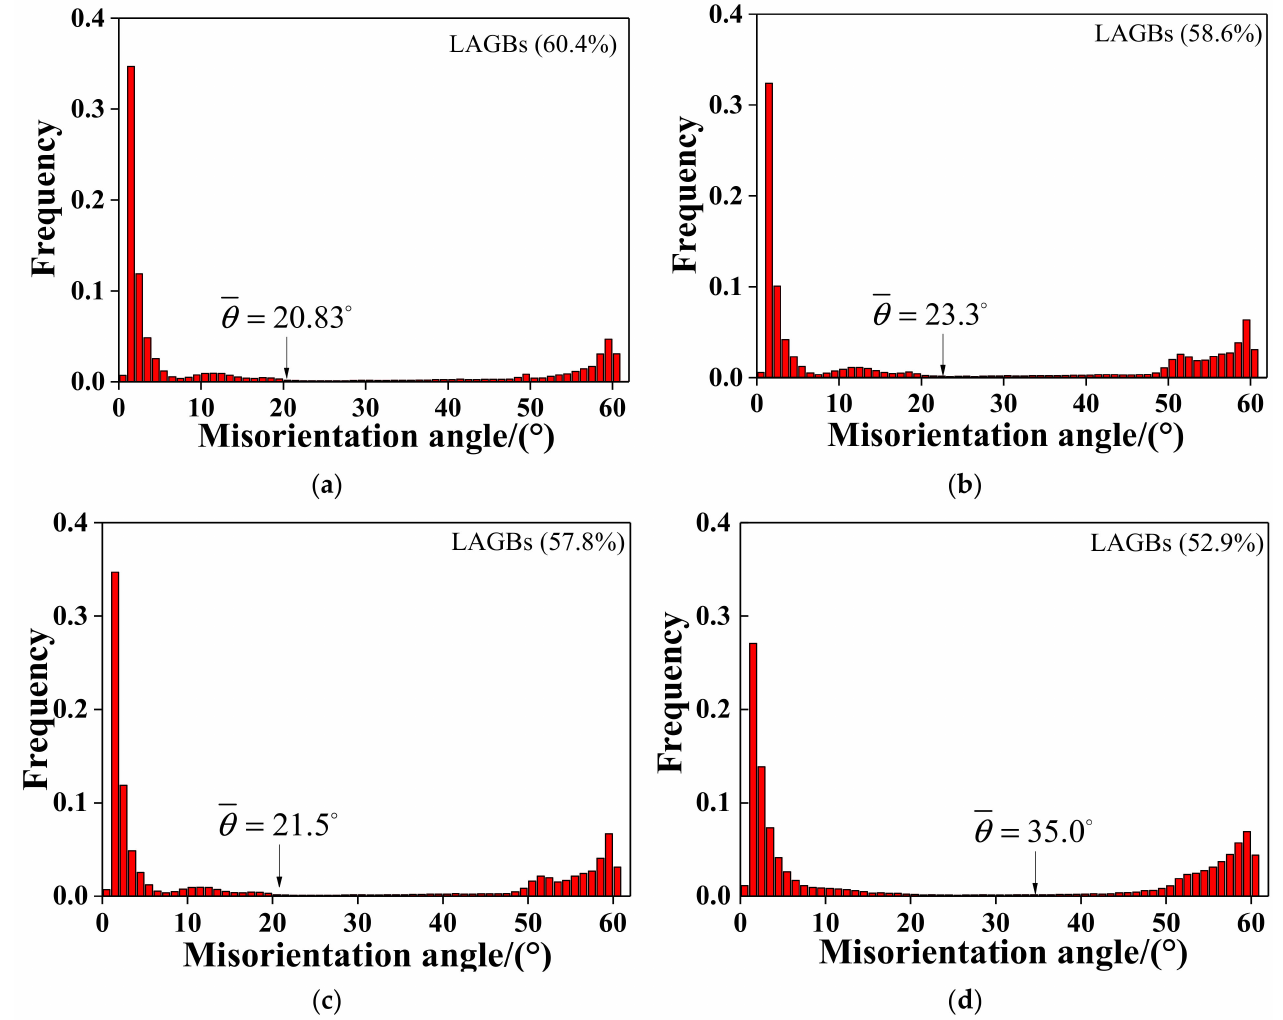
Figure 10. Distribution of grain boundary misorientation angles: ( a ) without ultrasonic 950 ◦ C, 0.1 s − 1 ; ( b ) without ultrasonic 1050 ◦ C, 0.1 s − 1 ; ( c ) with ultrasonic 950 ◦ C, 0.1 s − 1 ; ( d ) with ultrasonic 1050 ◦ C, 0.1 s − 1